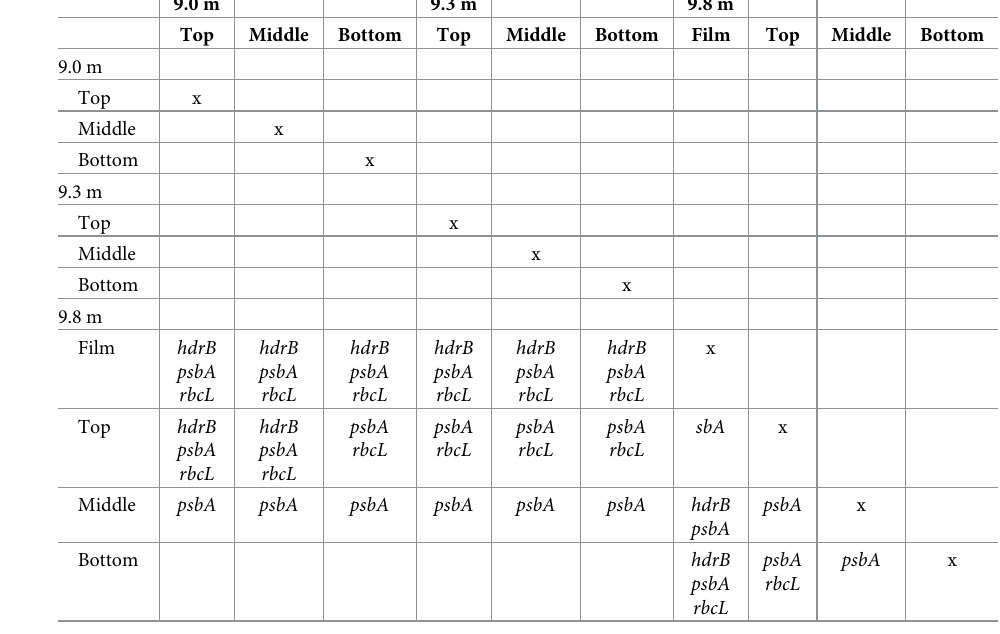
comparisons are marked